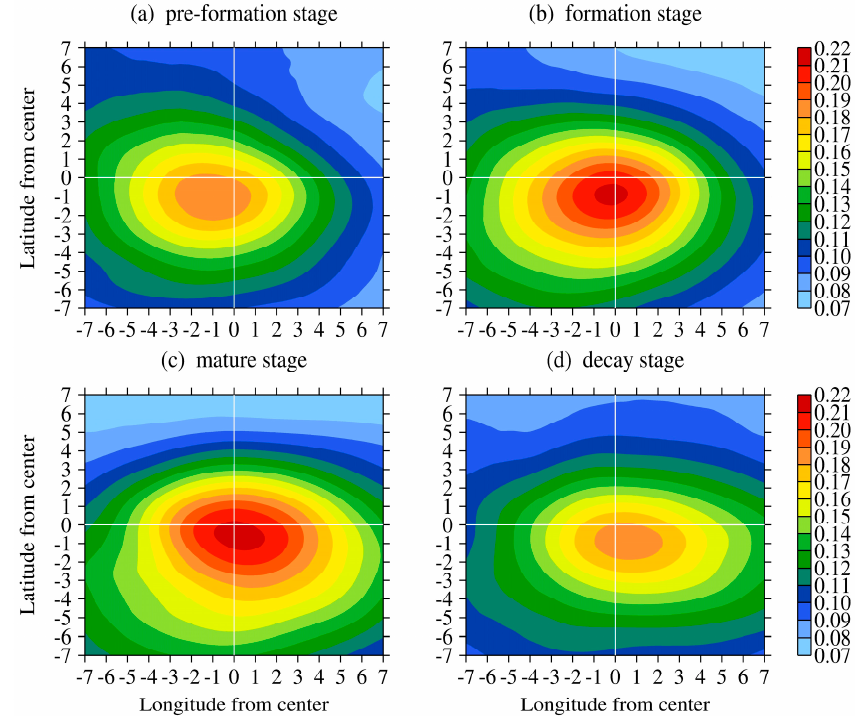
Figure A1. The statistical synthesis ozone concentration (unit: ppmv) at 300 hPa in the research region at four stages: the pre-formation stage ( a ), formation stage ( b ), mature stage ( c ), and decay stage ( d ).